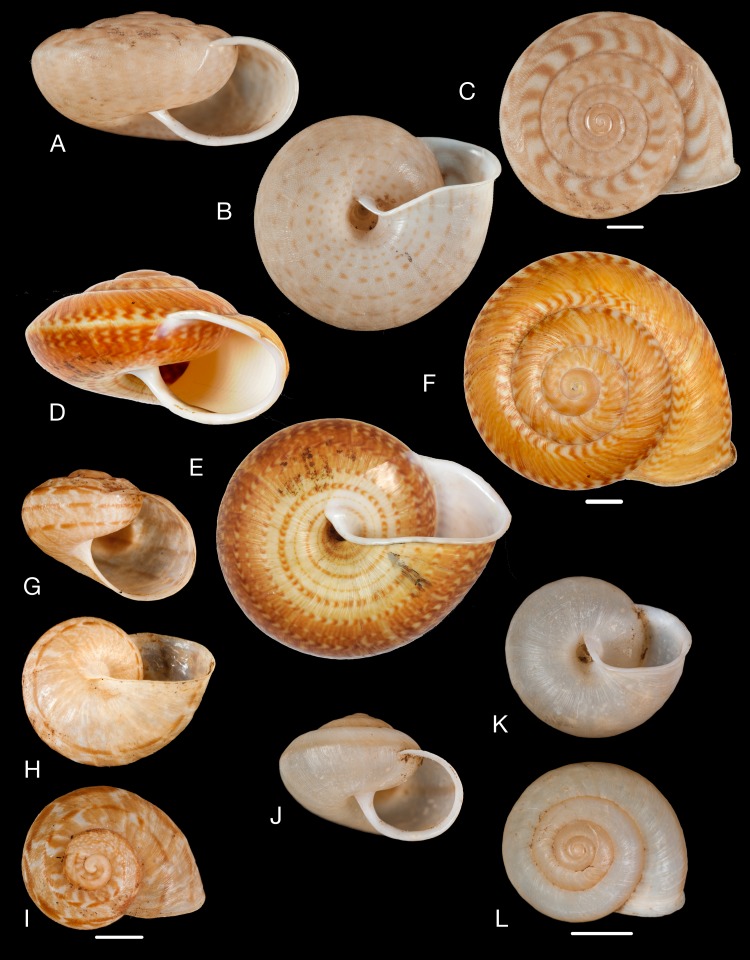
Material collected by the CCP.(A–I) Pleurodontidae. Solaropsis brasiliana (Deshayes, 1832), MNCN 15.05/14082, (A) ventral view, (B) umbilical view, (C) apical view; Solaropsis gibboni (Pfeiffer, 1846), MNCN 15.05/3169, (D) lateral view (lip), (E) umbilical view, (F) apical view; Psadara quadrivittata (Hidalgo, 1869), MNCN 15.05/3193, (G) ventral view, (H) umbilical view, (I) apical view. (J–L) Bradybaenidae. Bradybaena similaris (Férussac in Rang, 1831), MNCN 15.05/13124, (J) ventral view, (K) umbilical view, (L) apical view. Scale line 5 mm (A–C, G–L), 1 cm (D–F).